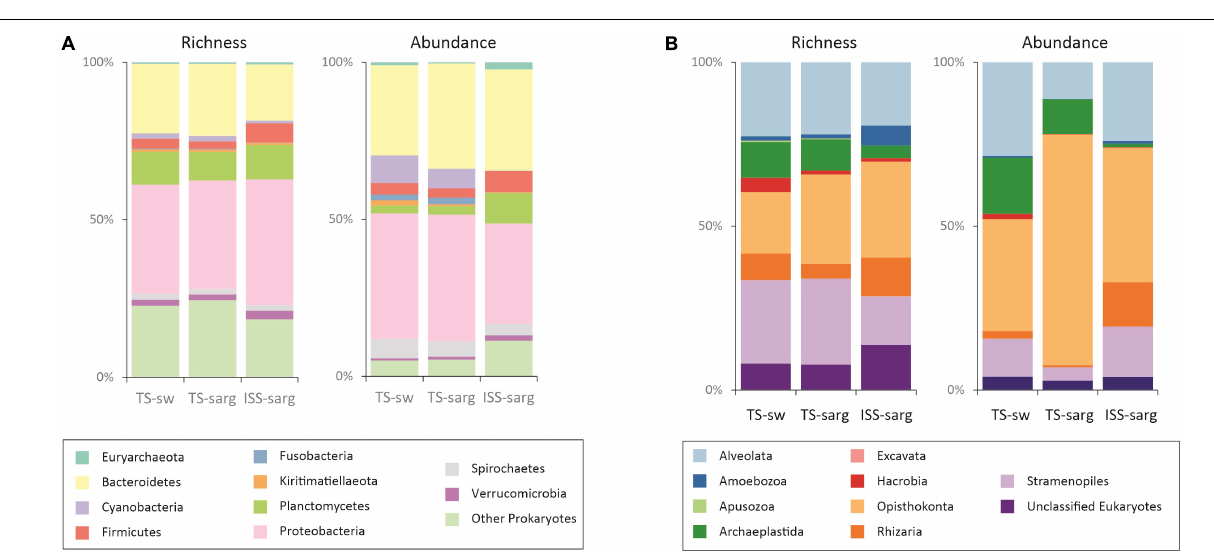
( Supplementary Figure 8 ), corresponding to members of 4 archaeal and 41 bacterial